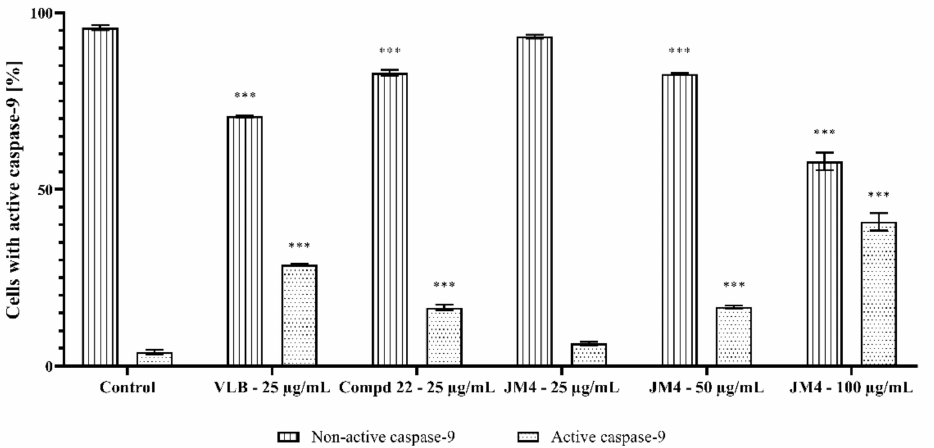
Figure 16. Percentage of C32 melanoma cells with nonactive and active caspase-9 after 24 h incubation with JM4 (25, 50, 100 µ g/mL), 22 (25 µ g/mL) and vinblastine sulfate (VLB) (25 µ g/mL). Mean percentage values from three independent experiments ( n = 3) done in duplicate are presented. *** p < 0.001 versus control